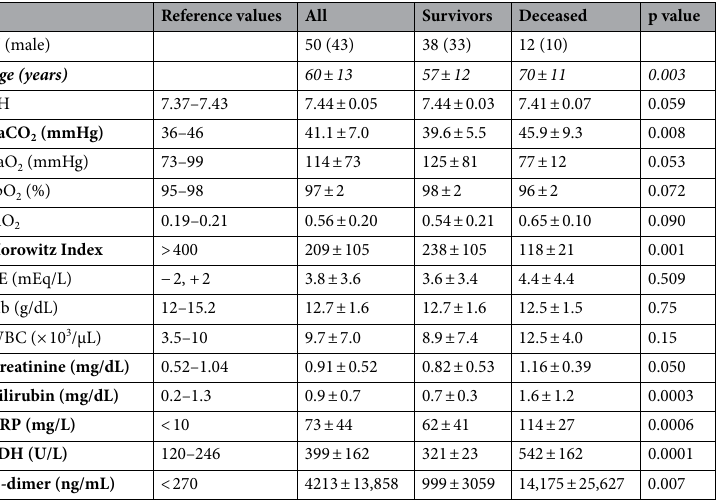
Table 1. Main data of recruited patients (mean ± SD). The parameters that differentiate for the patients’ outcomes are in bold. The prognostic factors selected to cluster patients in this study are in italics. p values were determined by Student t-test for unpaired